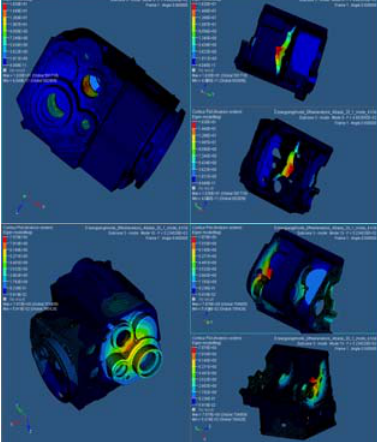
Fig.3. The 5 th and 7 th order mode of housing